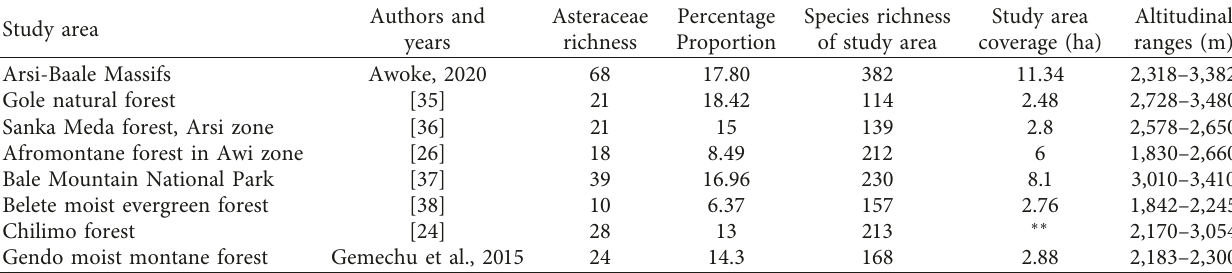
Table 2: Comparison of Asteraceae dominance in different vegetation types of Ethiopia.